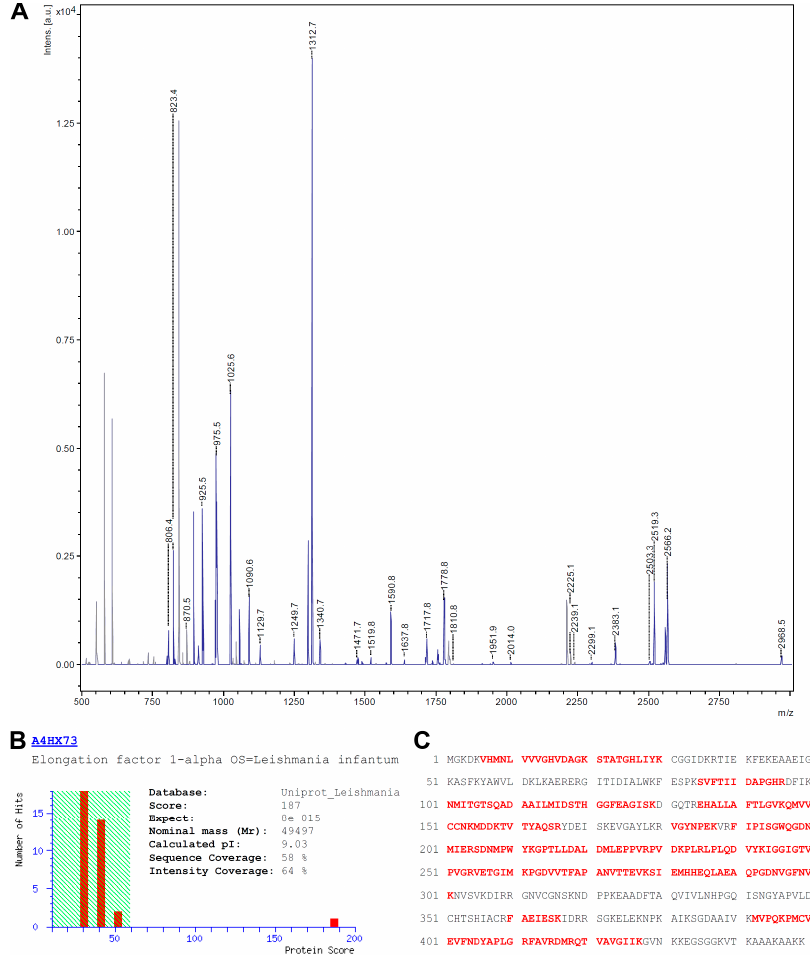
Figure 3. Identification of eEF1 α . ( A ) MS-Spectrum of the tryptic digest of the processed protein spot. Peaks matching to the sequence of eEF1 α are shown in blue; ( B ) Identification of eEF1 α with a MOWSE score of 187 (scores above 59 are significant; p < 0.05). The theoretical values for the molecular weight and pI correspond to the observed ones; ( C ) Sequence of eEF1 α with peptides identified by database search highlighted in red.